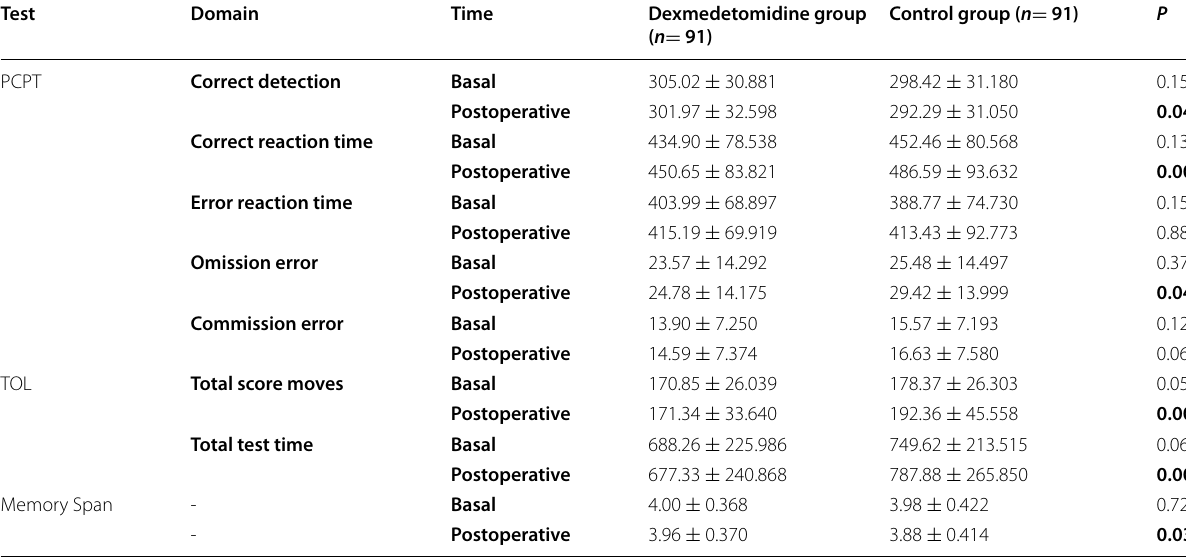
Table 3 Pre‑and postoperative PCPT, TOL, and memory span assessment in the studied groups